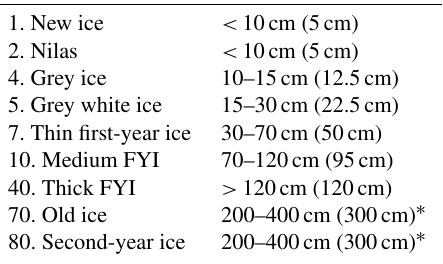
Table 1. CIS sea ice stages of development and their thickness ranges, with the values between brackets denoting the used average thickness of each